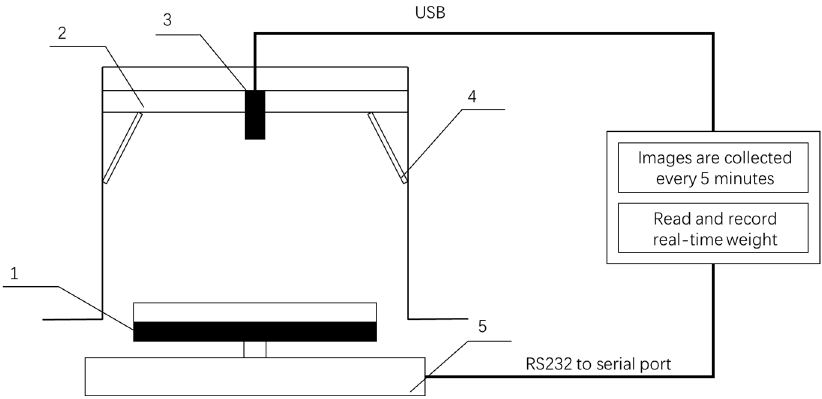
Figure 5. The Yinghong No. 9 tea leaves moisture content test platform: (1) Iron frame; (2) camera mount; (3) camera; (4) LED; (5) electronic scale.